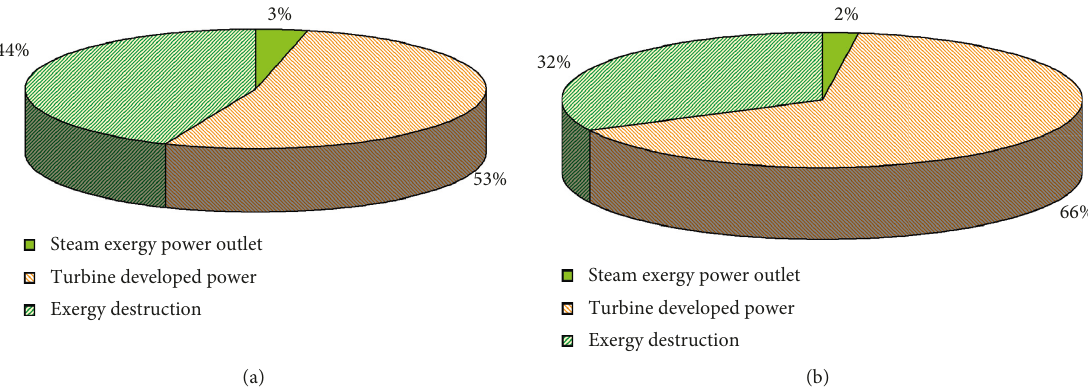
Figure 8: Distribution of steam turbine exergy power inlet for operating point 5 in exploitation (a) and at the maximum exergy efficiency (b).